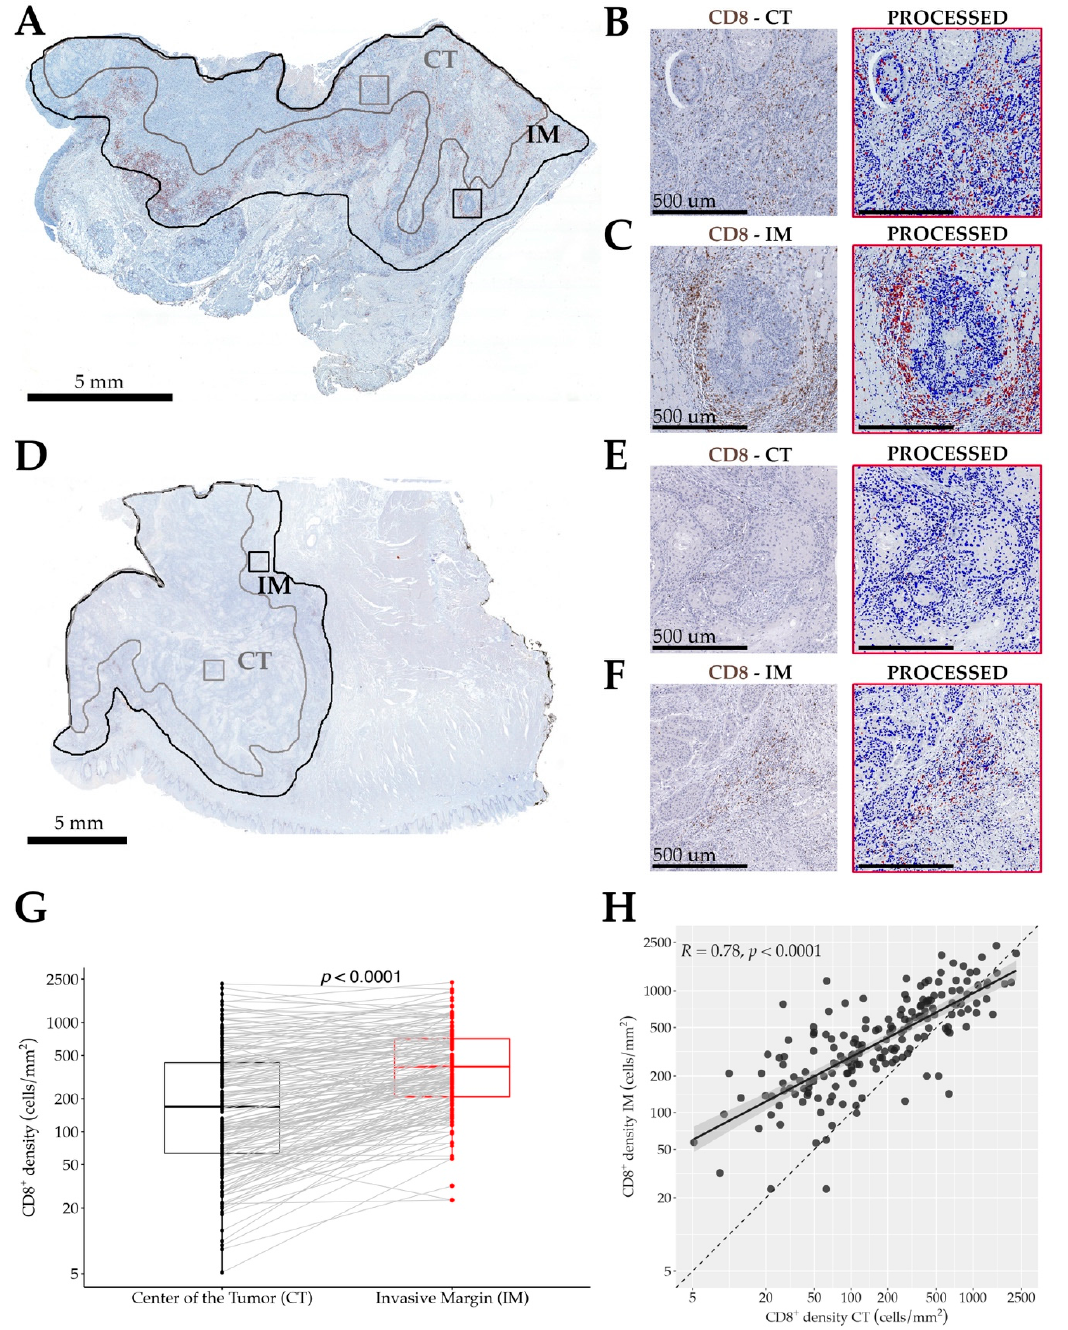
Figure 1. Panel showing whole tumor sections stained for CD8 in two representative cases ( A – C and D – F ). In ( A ) and ( D ) , the selection of areas of interest is shown: the center of the tumor (CT) and the invasive margin (IM)—whilst the black line defines the whole tumoral bed. Representative high magnification immunostained ( left ) and processed ( right ) sections showing the immune cells recognition and counting algorithm ( B , C , E , F ). In ( B ) and ( C ) , the example fields of 1 mm 2 of the case presented in ( A ) taken from the CT (554 CD8 + T-cells) or IM (1159 CD8 + T-cells), respectively. In ( E ) and ( F ) , the example fields of 1 mm 2 of the case presented in ( D ) are taken from the CT (26 CD8 + T-cells) or IM (294 CD8 + T-cells), respectively. The box plots ( G ) show a higher density of CD8 + T-cells in the IM compared to the CT (grey lines connecting the measures of CD8 + T-cell density in each single patient) and the scatter plot ( H ) illustrates a significant direct correlation of CD8 + T-cells’ density between those regions ( H ); p values estimated by the Wilcoxon matched-pairs signed rank test ( G ) or Spearman rank correlation test ( H ). Scale bars: ( A , D ), 5 mm; ( B , C , E , F ), 500 µm.